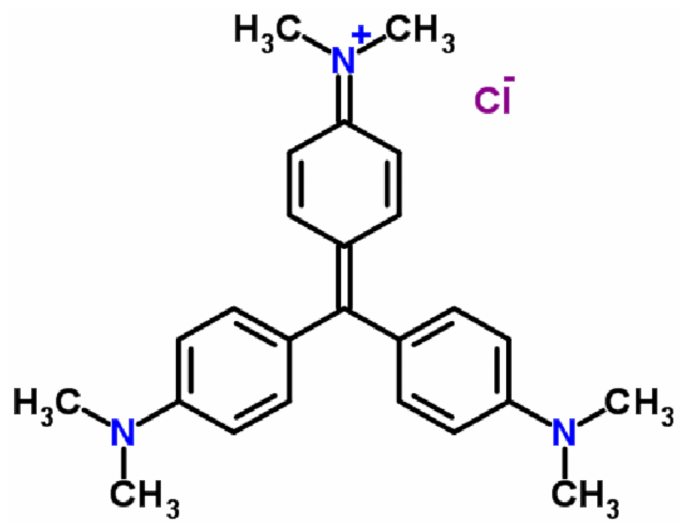
Figure 1. Structure of crystal violet